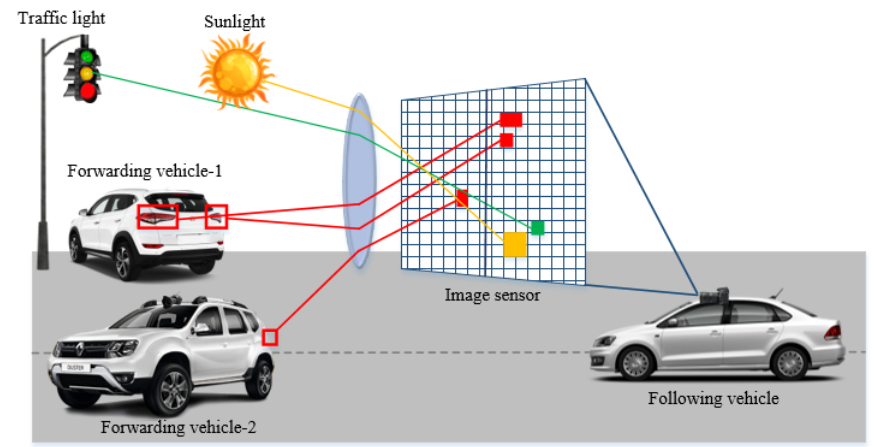
Figure 1. OCC-based vehicle localization scenario from the rear LED shapes of the vehicles. Three general on-road scenarios are considered here, i.e., the vertical distance between FWVs and FLVs can increase or decrease, the FWVs can move laterally, and the FWVs can turn either left or right. In the first two cases, both rear LED sizes remain equal, but in the last case, they become unequal. The size of the LEDs in the captured image decreases with an increase in distance, whereas the coordinates of the LEDs varies with the lateral movement of the FWVs, FLVs, or both, as shown in Figure 2a–c. This distance can be calculated with the variation in LED size; after a certain distance, the LEDs become too small to be detectable. This system will work provided that the projected LED image on the IS covers a minimum of a one-unit pixel area. This system can also be integrated with an RF system in such a way that when the LED size falls below the threshold level, it will switch to the RF network. However, vehicles at a large distance impose a smaller threat than closer vehicles do. Thus, a hybrid system for large distance estimation is considered superfluous.